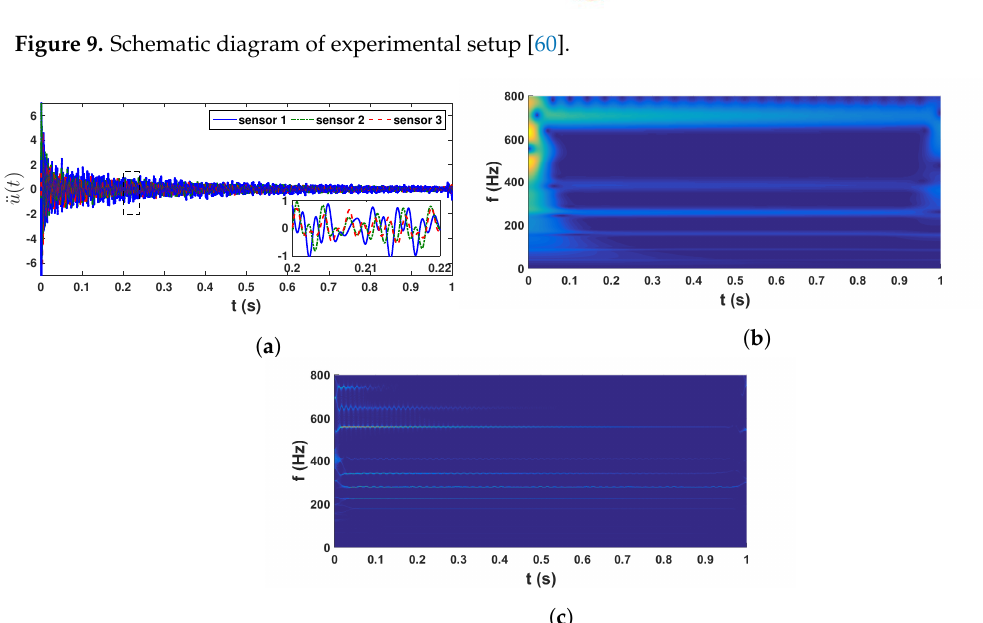
Figure 10. Recorded beam response in test 1 and Scalogram; ( a ) accelerations in three channels; ( b ) wavelet scalogram of sensor 2 & ( c ) synchrosqueezed scalogram of sensor